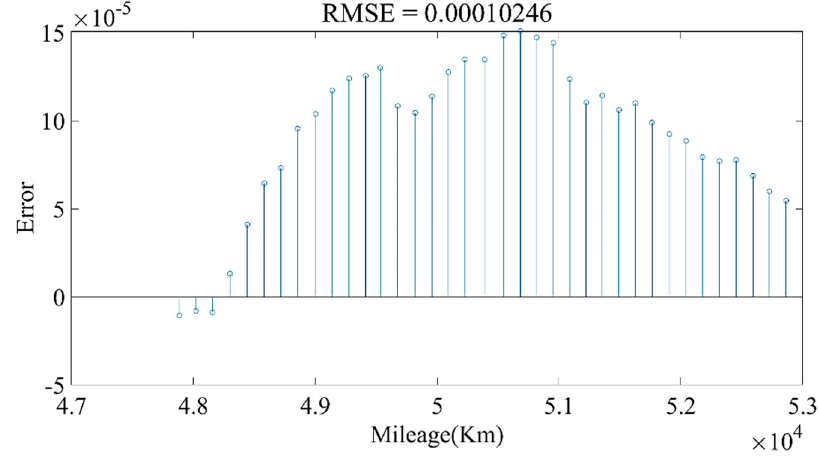
Figure 28. The RMSE of LSTM.